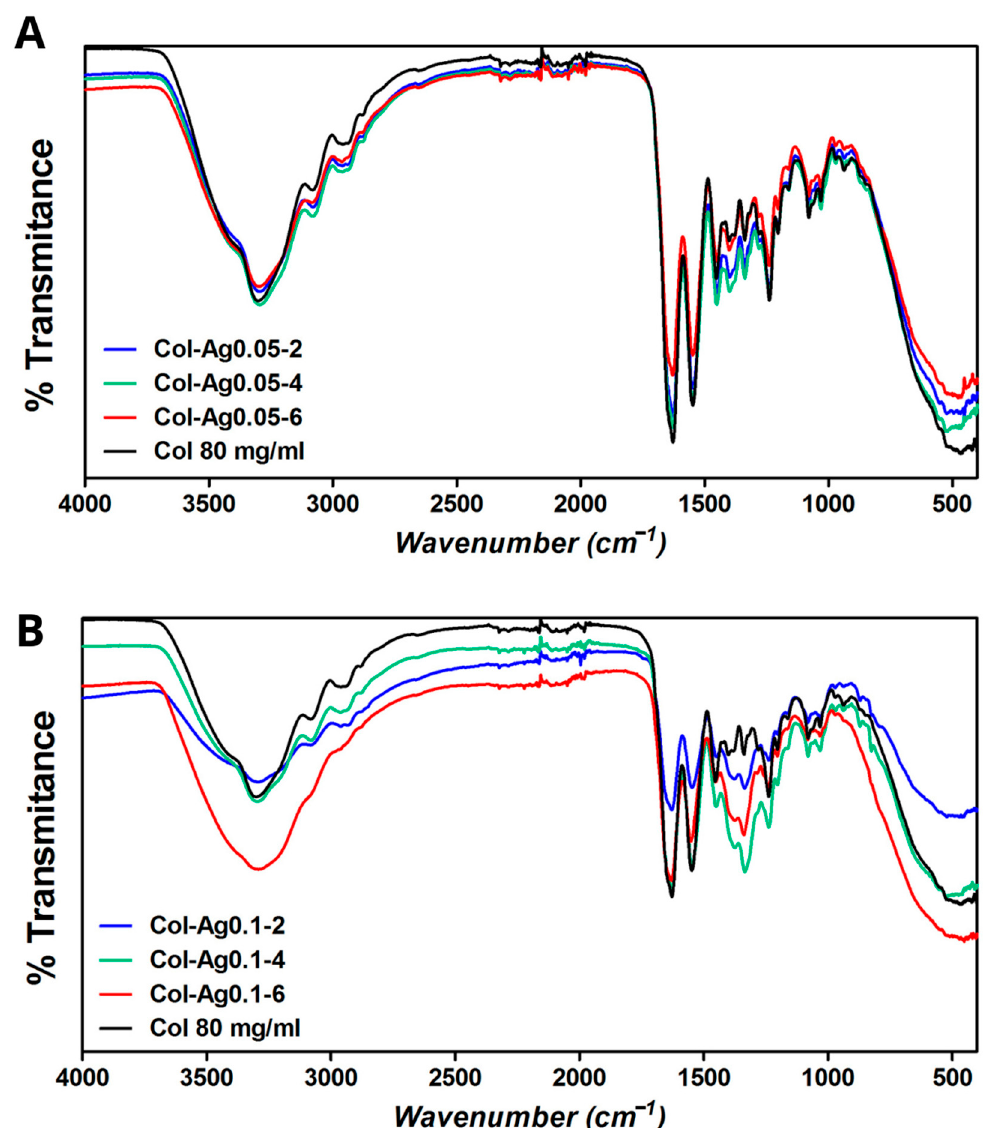
Figure 4. FTIR spectra of Col, Col-Ag0.05 ( A ), and Col-Ag0.1 ( B ) after different time of UV light exposure (0 h, 2 h, 4 h, and 6 h).